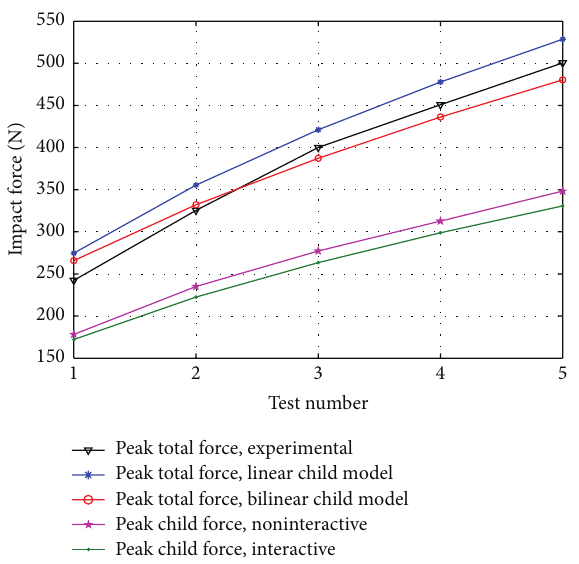
Figure 6: Comparison of the measured and estimated peak impact